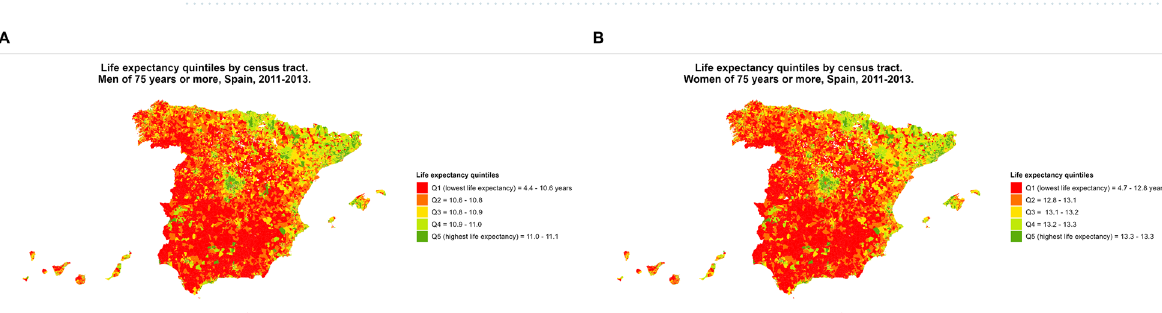
Figure 3. Life expectancy quintiles at birth by province and sex ( A : men, B : women) in Spain, 2011–2013.